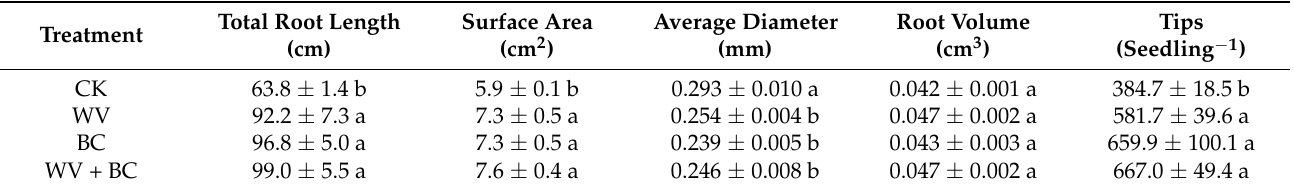
Table 5. Seedling root morphology of different seed treatments of WDR under dry direct-seeded system under growth chamber experiment.